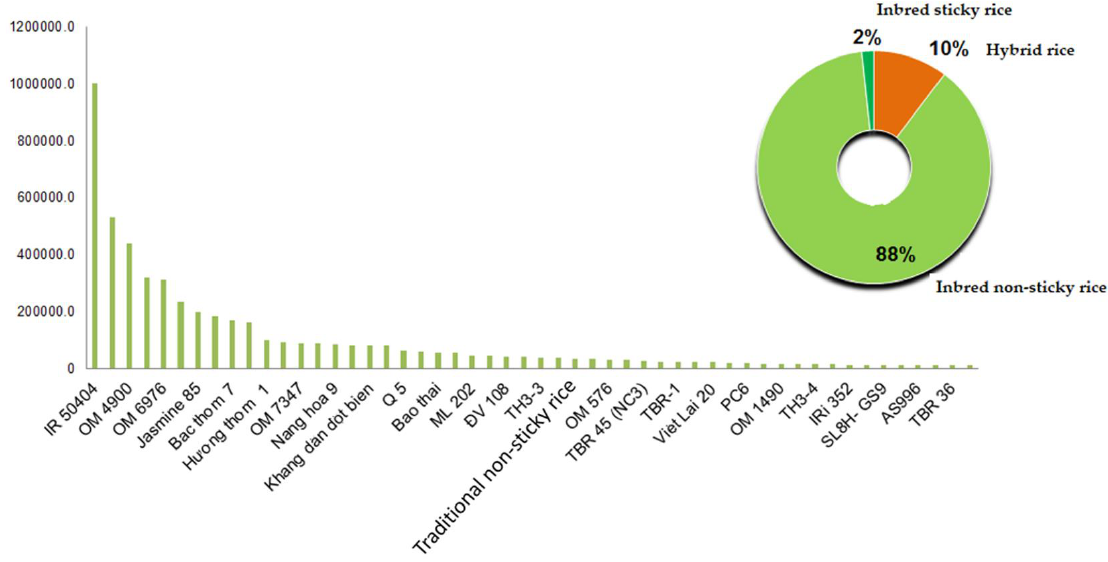
Figure 5. The structures of rice varieties grown in Vietnam.